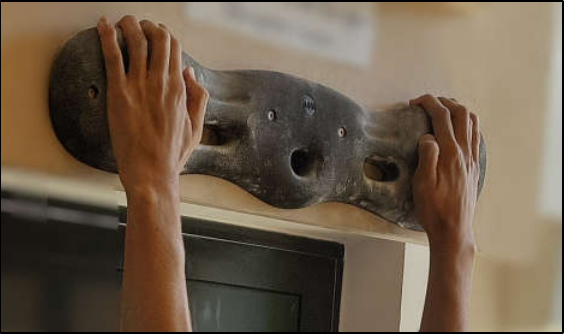
Figure 1. Hand positioning on the fingerboard.